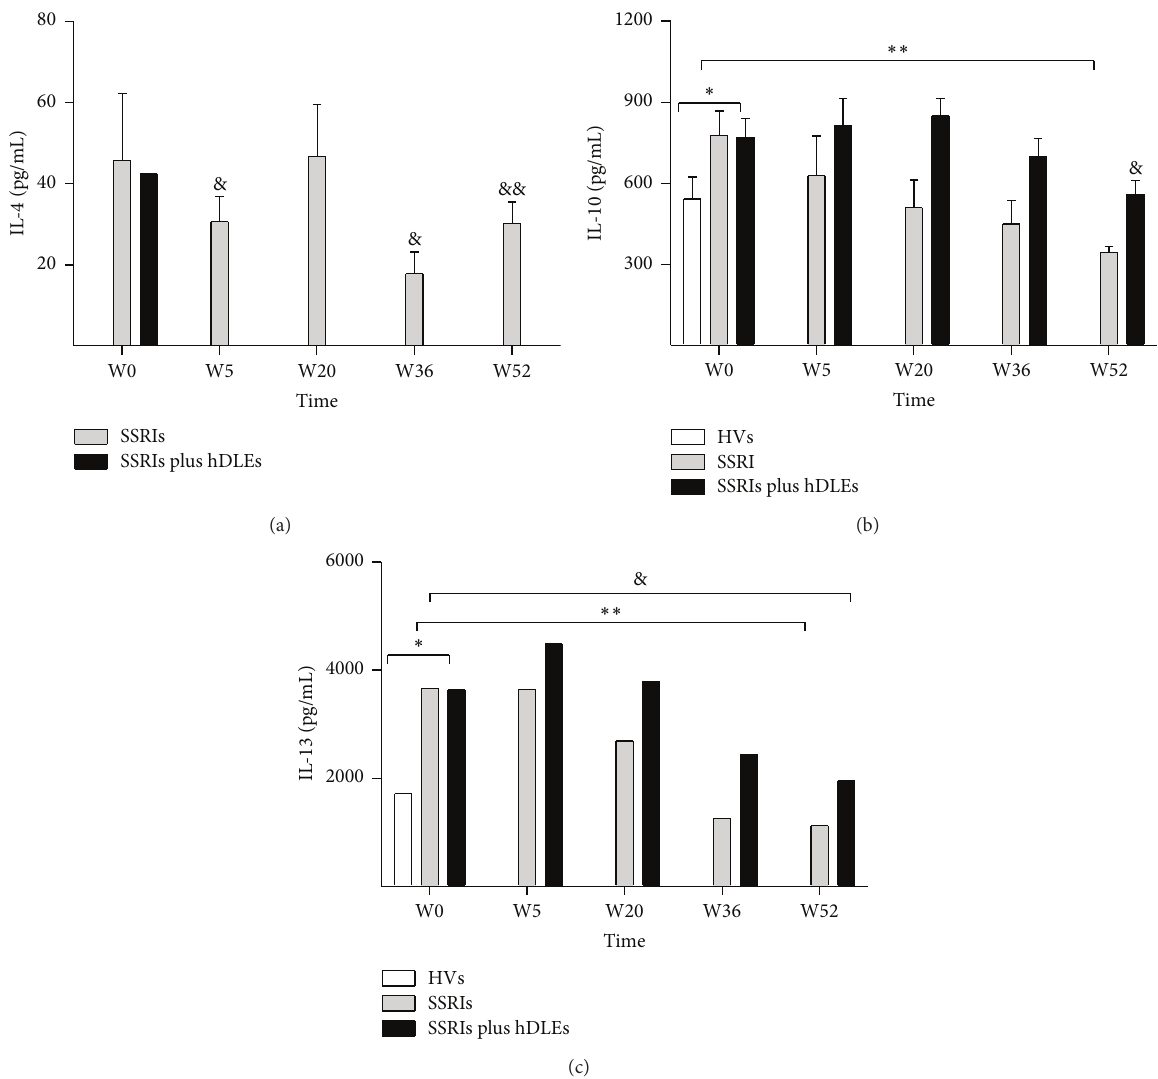
Figure 4: Serum anti-inflammatory cytokines detected by capture ELISSA assay in HVs and MDD patients. Patients were treated with SSRIs or SSRIs plus hDLEs during 52 weeks of study. The statistical analyses were as follows. First, the patient group before antidepressant treatment (W0) was compared with the control group (HVs). Second, the values before the antidepressant treatments (W0) were compared with those during the treatment (W5, W20, W36, or W52) in patients. Third, the data of patients at W52 versus HVs were compared. IL-4 (a), IL-10(b), and IL-13 (c). HVs were not detectable. IL-4: & 𝑃 < 0.0001 SSRIs treatment at (W) 5 and 36 versus W0. && 𝑃 < 0.001 between SSRIs treatment at W52 versus W0. IL-10 and IL-13: ∗ 𝑃 < 0.0001 , significant difference before treatments versus HVs. IL-10: ∗∗ 𝑃 < 0.001 between SSRIs treatment at (W) 5, 20, and 36 versus W0. & 𝑃 < 0.0001 between SSRIs plus hDLEs treatment at W52 versus HVs. IL-13: ∗∗ 𝑃 < 0.001 between SSRIs treatment at (W) 5, 20, and 36 versus W0. & 𝑃 < 0.0001 between SSRIs plus hDLEs treatment at (W) 5, 20, 36, and 52 versus W0. Data are expressed as mean ± SD. HVs: healthy volunteers; MDD: major depression disorder; W: